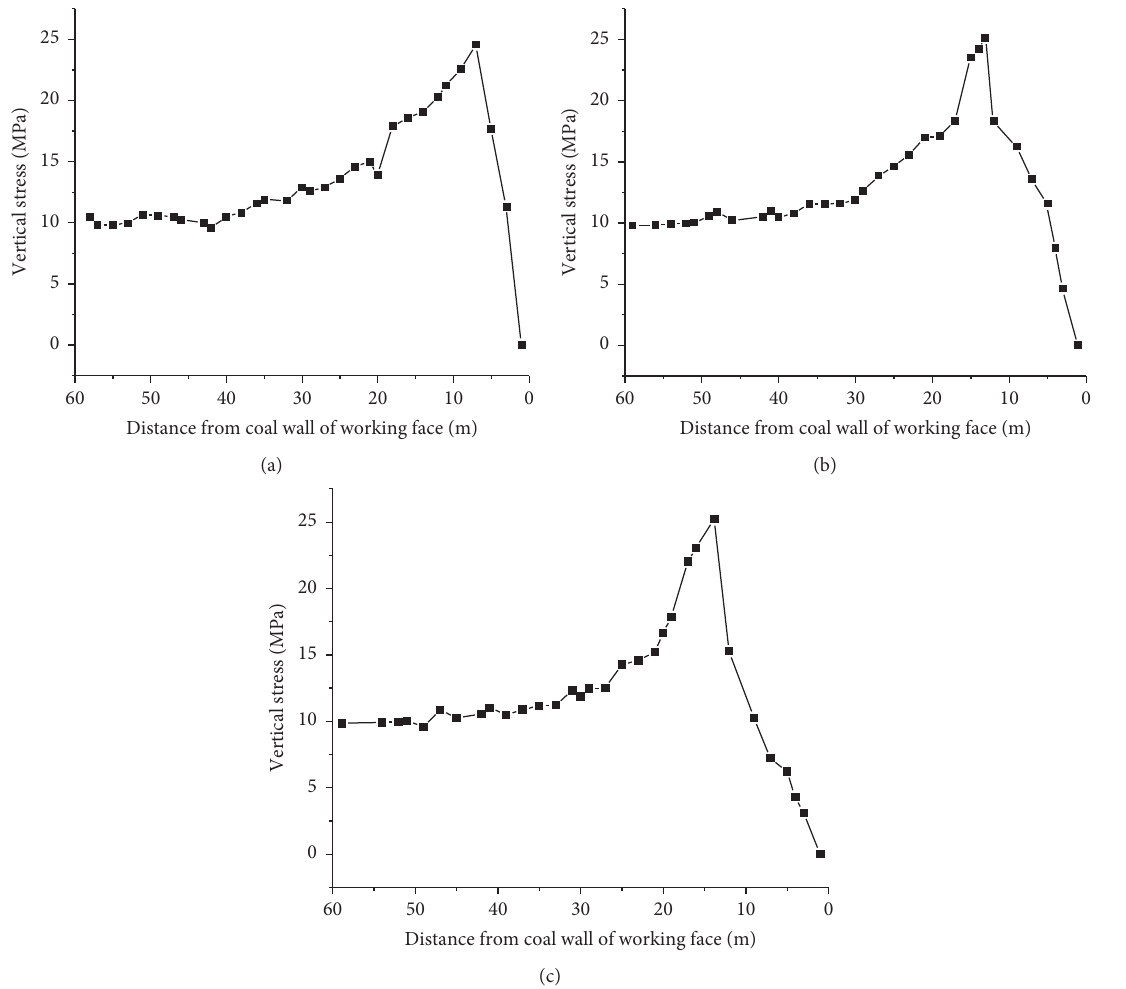
Figure 25: Variation curve of advance abutment pressure. (a) 2# (5m) measuring point. (b) 4# (10m) measuring point. (c) 5# (12m) measuring